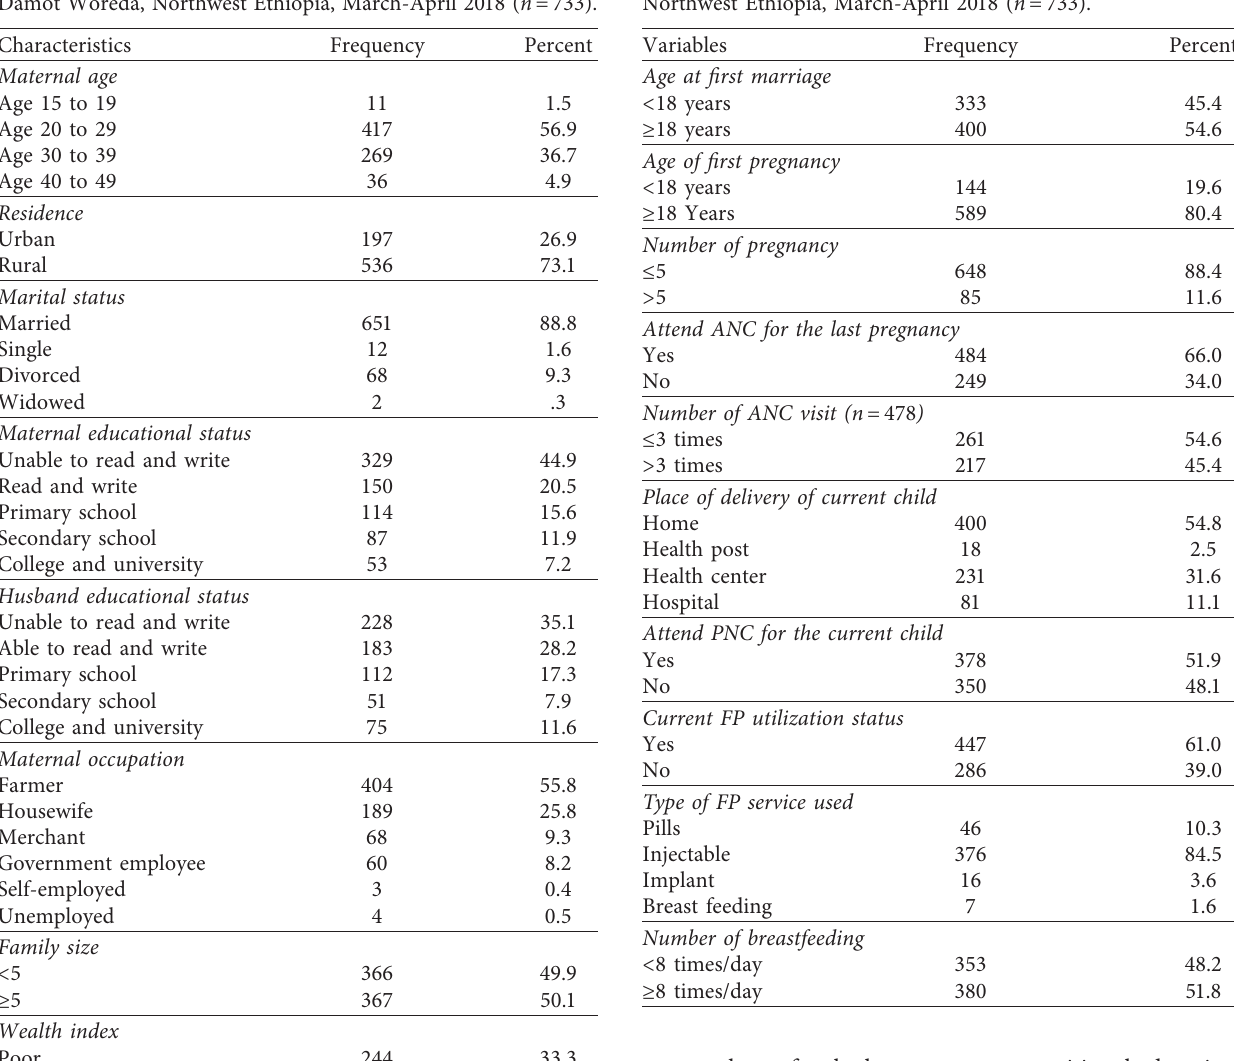
Table 2: Obstetric factors of the study respondents among lactating Table 1: Sociodemographic characteristics of the respondents